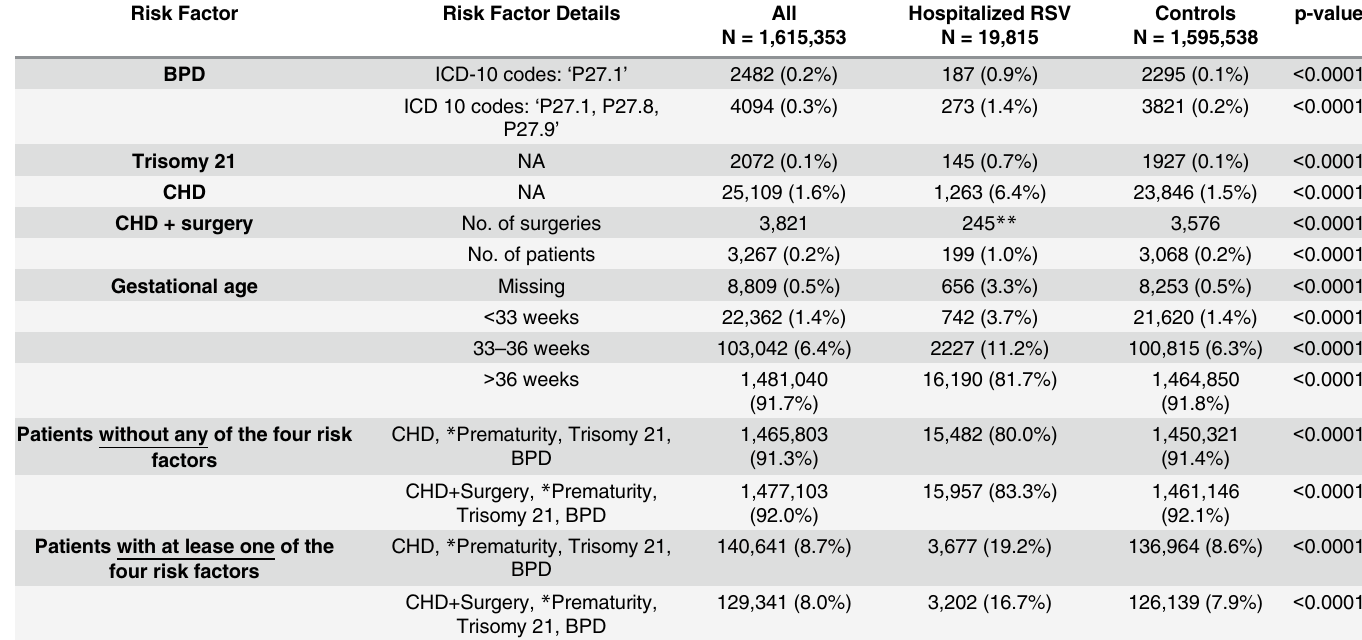
Table 3. Prevalence of major RSV risk factors in Ontario children less than 3 years.